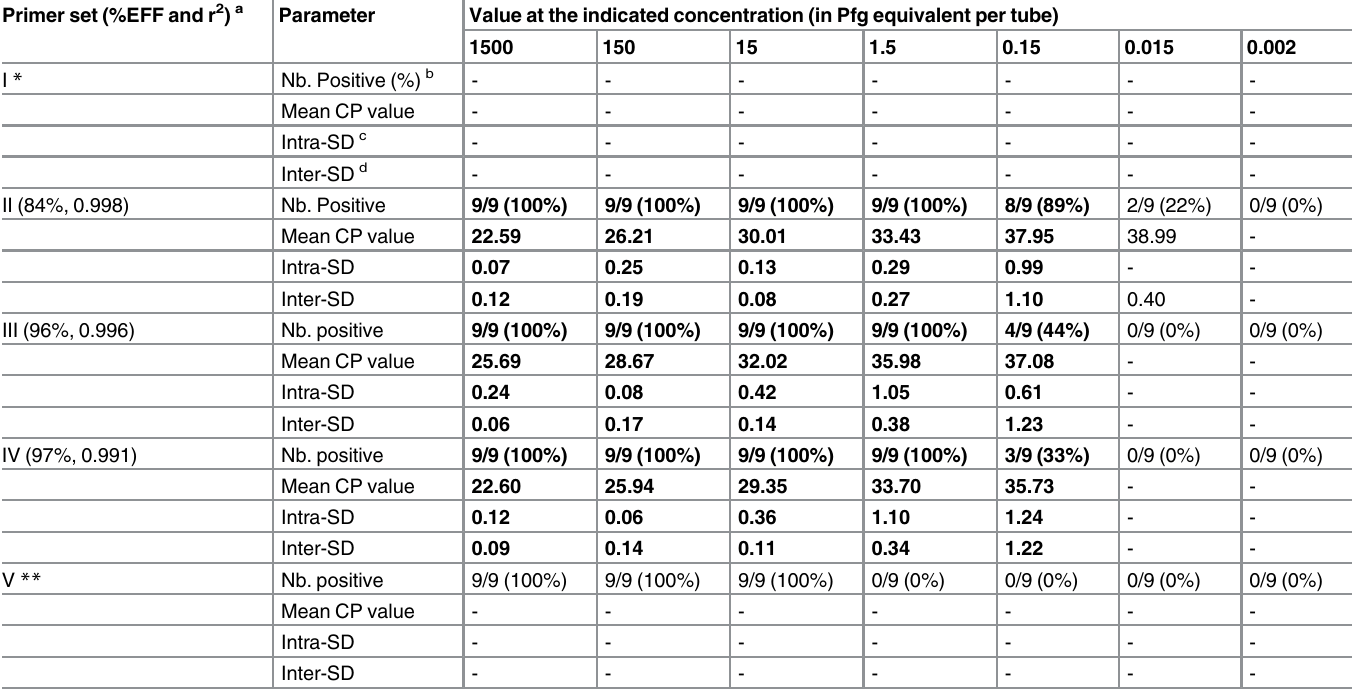
Table 5. Results of the assessment of each primer set on calibrated standards of Plasmodium falciparum sporozoites. Primer set (%EFF and r 2 ) a